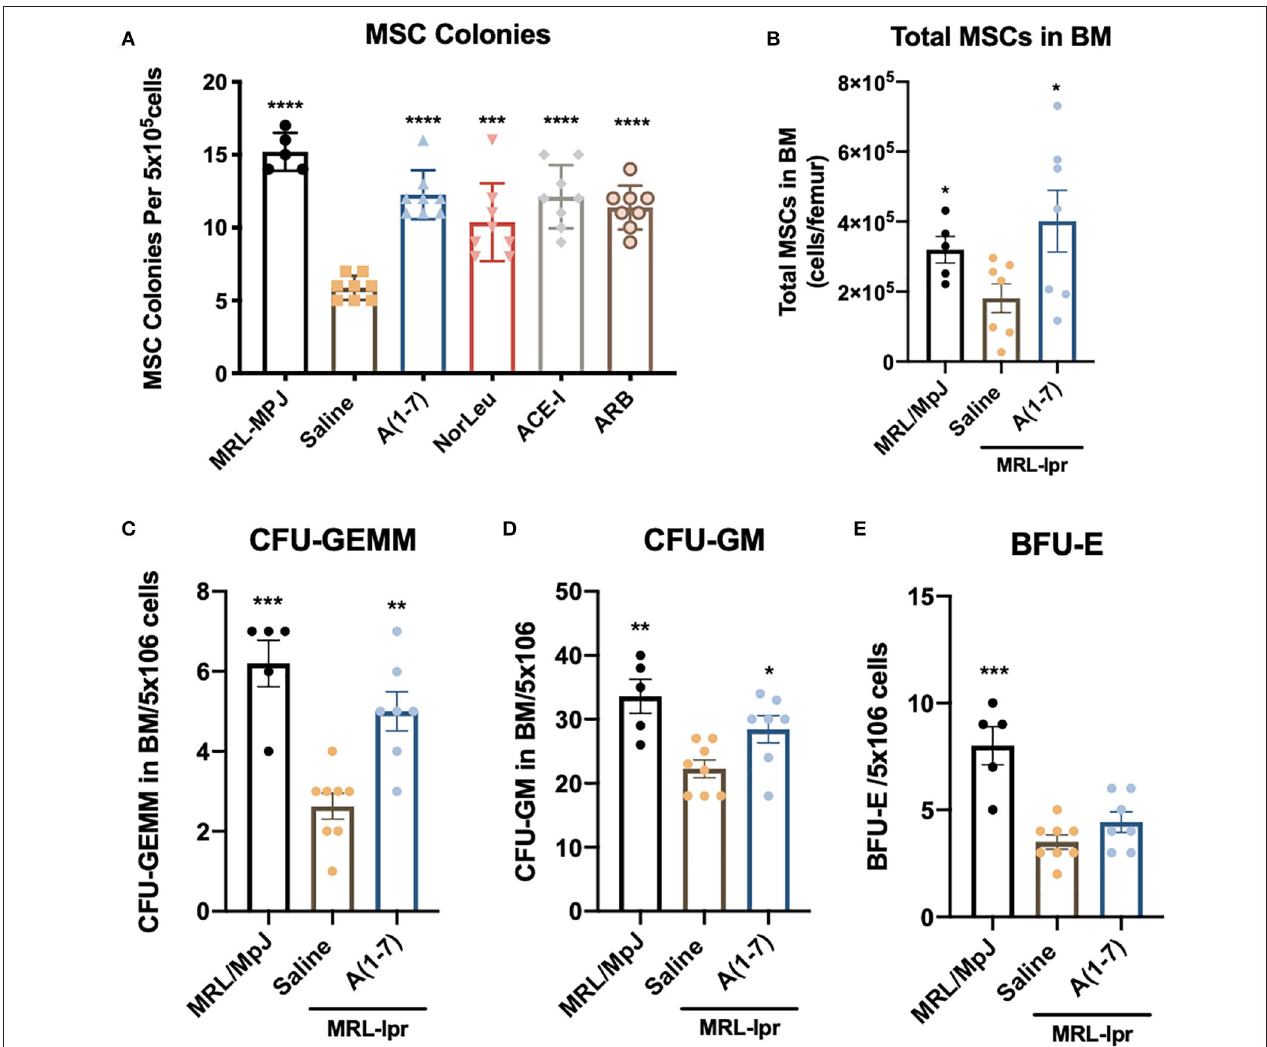
FIGURE 7 | BM stem cells are diminished in MRL -lpr mice and rescued by RAS modulation. BM from the both femurs was collected at necropsy. (A) Cells were plated on MesenCult TM media and 7 days later the number of MSC-CFUs was counted. (B) Flow cytometry was used to measure the number of MSCs (CD45 − CD29 + Sca-1 + CD105 + ) per femur, the gating strategy is outlined in Supplemental Figure 1 . BM cells were also plated on MethoCult TM media and the CFU-GEMM (C) CFU-GM (D) and BFU-E (E) were measured as per manufacturer’s instructions. Statistics were run using Prism 8.4.0, t -tests were used to compare all groups to saline treated MRL -lpr mice; * p ≤ 0.05, ** p ≤ 0.01, *** p ≤ 0.001, **** p ≤